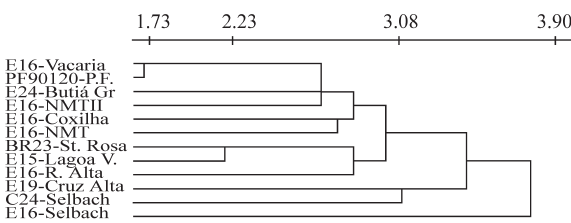
Figure 7 - Dendrogram of the relationships between Drechslera tritici- repentis isolates based on random amplified polymorphic DNA (RAPD) analysis